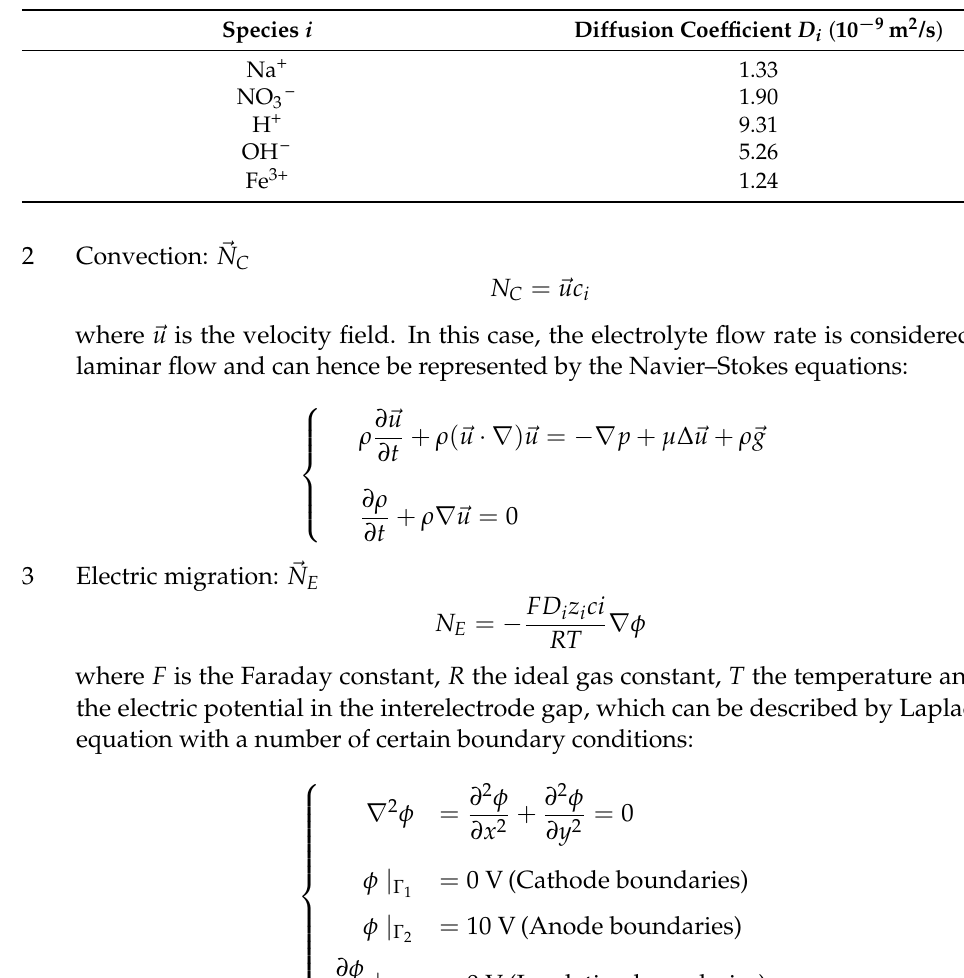
Table 2. Diffusion coefficients at